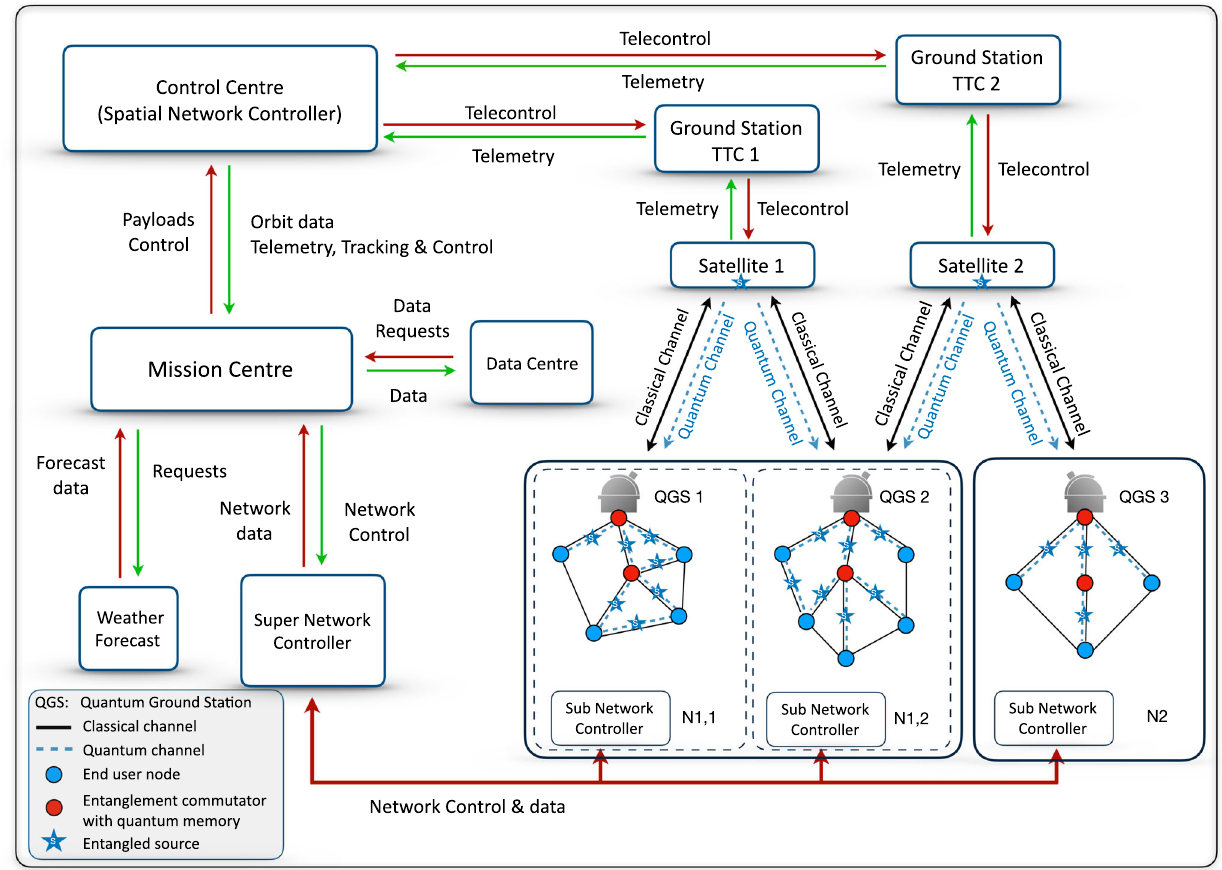
Fig. 2 Functional diagram of an integrated quantum information network with Space segment. The sub- and super-network controllers manage the ground networks. The super-network controller communicates through the mission centre with the control centre in order to manage both the quantum and classical channels between the satellites and the Quantum Ground Stations